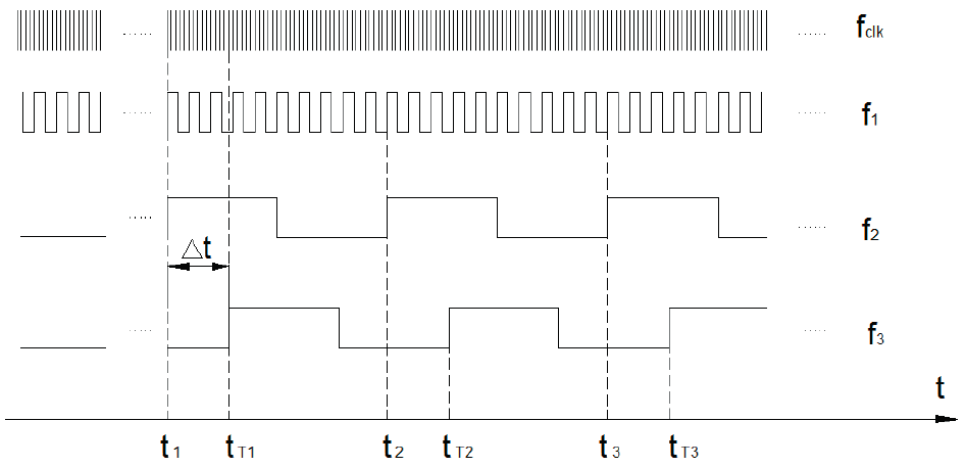
Figure 7. Time sequence of synchronization